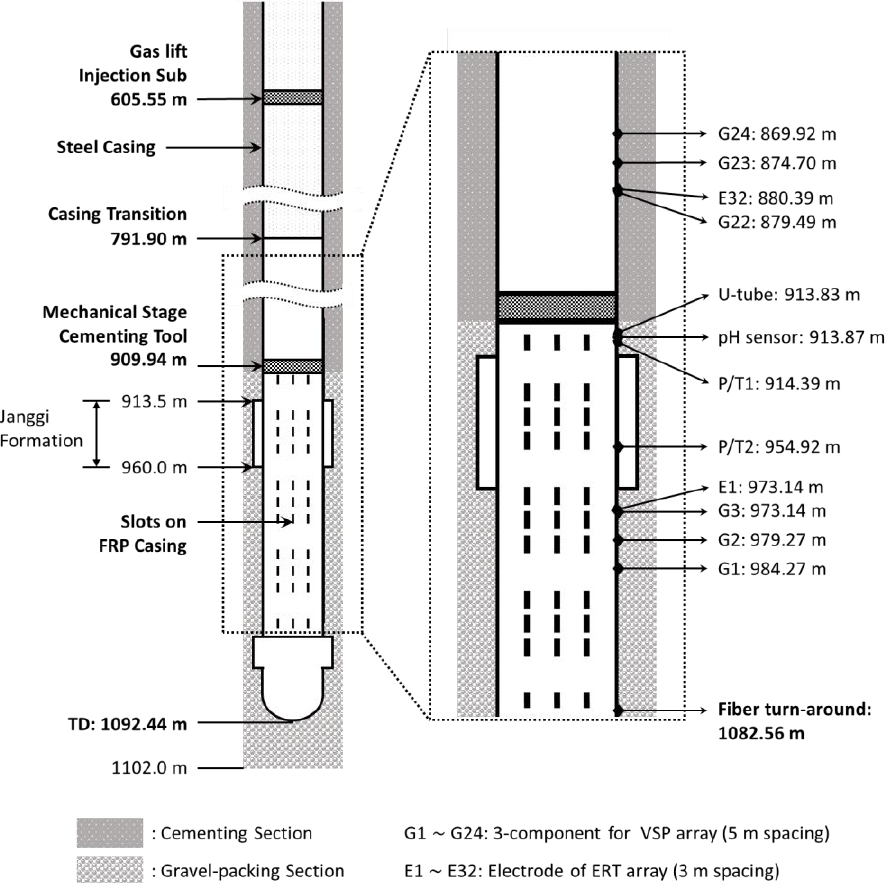
Figure 2. Schematic of the monitoring well, JG-M and the completion assembly employed with gravel packing and cementing.